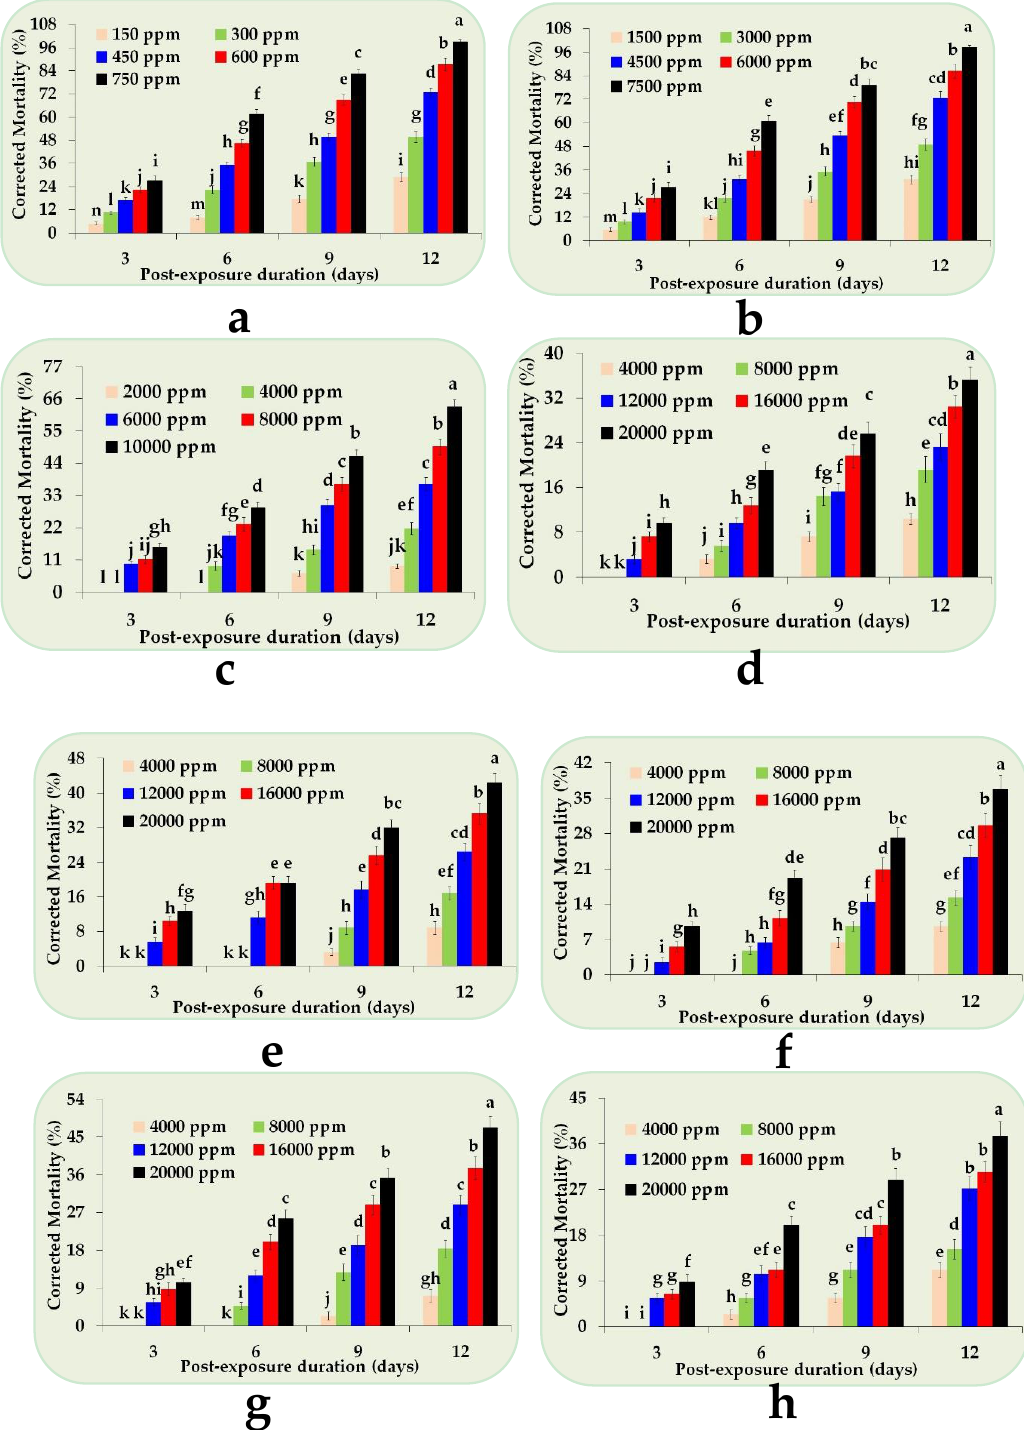
Figure 1. Corrected cumulative (%) dose mortality response of red palm weevil larvae against ( a ) Picrotoxin; ( b ) Farnesol; ( c ) Farnesyl acetate; ( d ) β -Caryophyllene; ( e ) (+)-Cedrol; ( f ) Nerolidol; ( g ) (+)-Nootkatone; and ( h ) Parthenolide. Each bar (mean ± SE) is the mean of five replicates. The bars followed by di ff erent letter(s) are significantly di ff erent (Fisher’s Least Significant Di ff erence test, α =